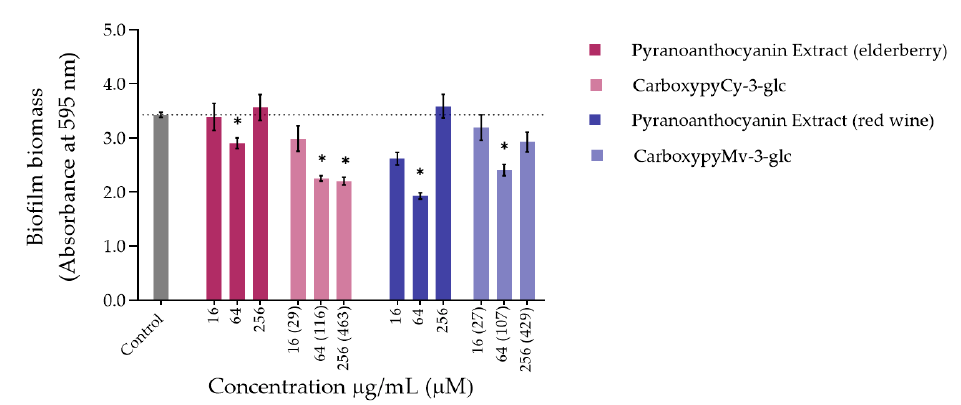
Figure 2. Biomass quantification of biofilms of P. aeruginosa ATCC 27853 formed in the absence (control) and in the presence of different concentrations of extracts or compounds: 256 µ g/mL, 64 µ g/mL and 16 µ g/mL. Statistically significant differences between biofilms formed in presence of the extract/compound and control biofilm ( p < 0.05) are marked with an asterisk.